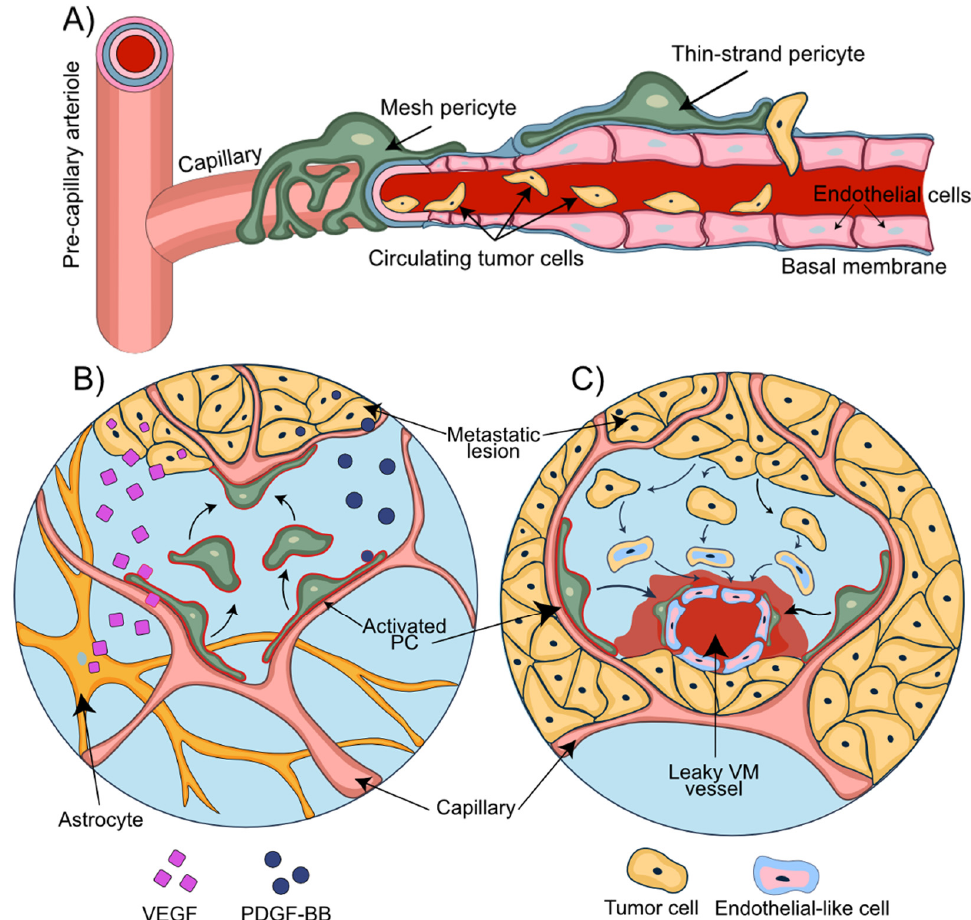
Figure 3. Pericytes support the disruption of the NVU during metastasis. ( A ) A consecutive process of rolling, adhesion, and transendothelial migration of circulating tumor cells results in the extravasation of the metastatic breast cancer cells. ( B ) Tumor and astrocyte-secreted VEGF contributes to vessel co-option. PDGF-BB secreted by the metastatic tumor cells mediates displacement of pericytes and their relocation towards the co-opted and newly formed blood vessels. ( C ) Transformation of the tumor cells into endothelial-like cells allows the formation of the vascular mimicry vessels. Pericytes migrate towards these newly formed leaky vascular mimicry vessels and stabilize them.